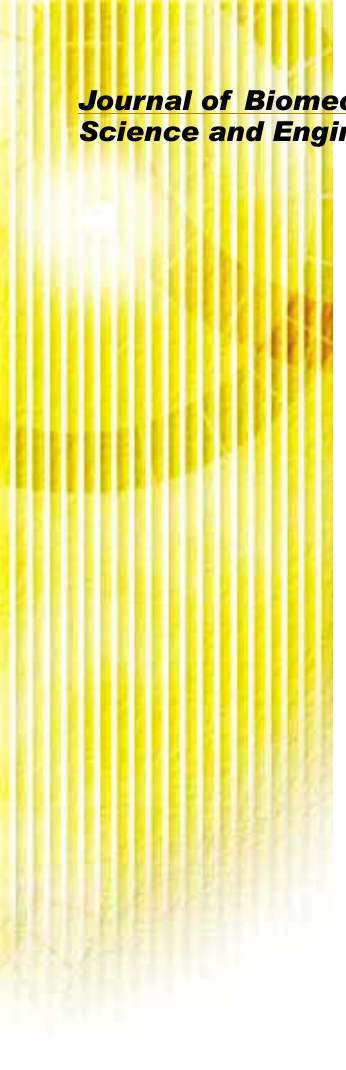
Fig.7 Frequency patterns of normalized attenuation at different distances between measurements sites ( d =5cm, d =15cm and d =20cm) obtained by the four methods. Data point are the mean and bars standard error of ten noise